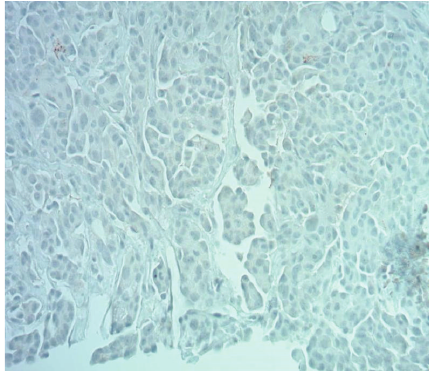
Figure 7: Lung biopsy: Napsin A immunostain 200x in lung is pos-